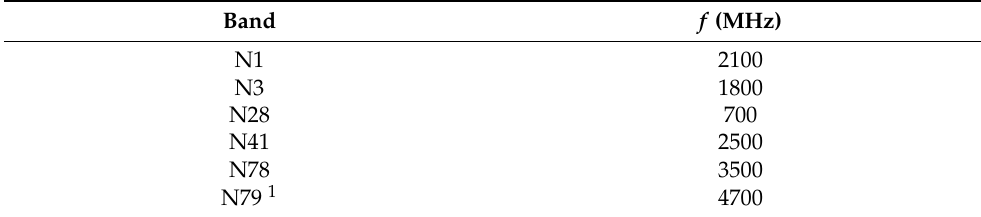
Table 2. Commercially Available 5G Frequency Bands in